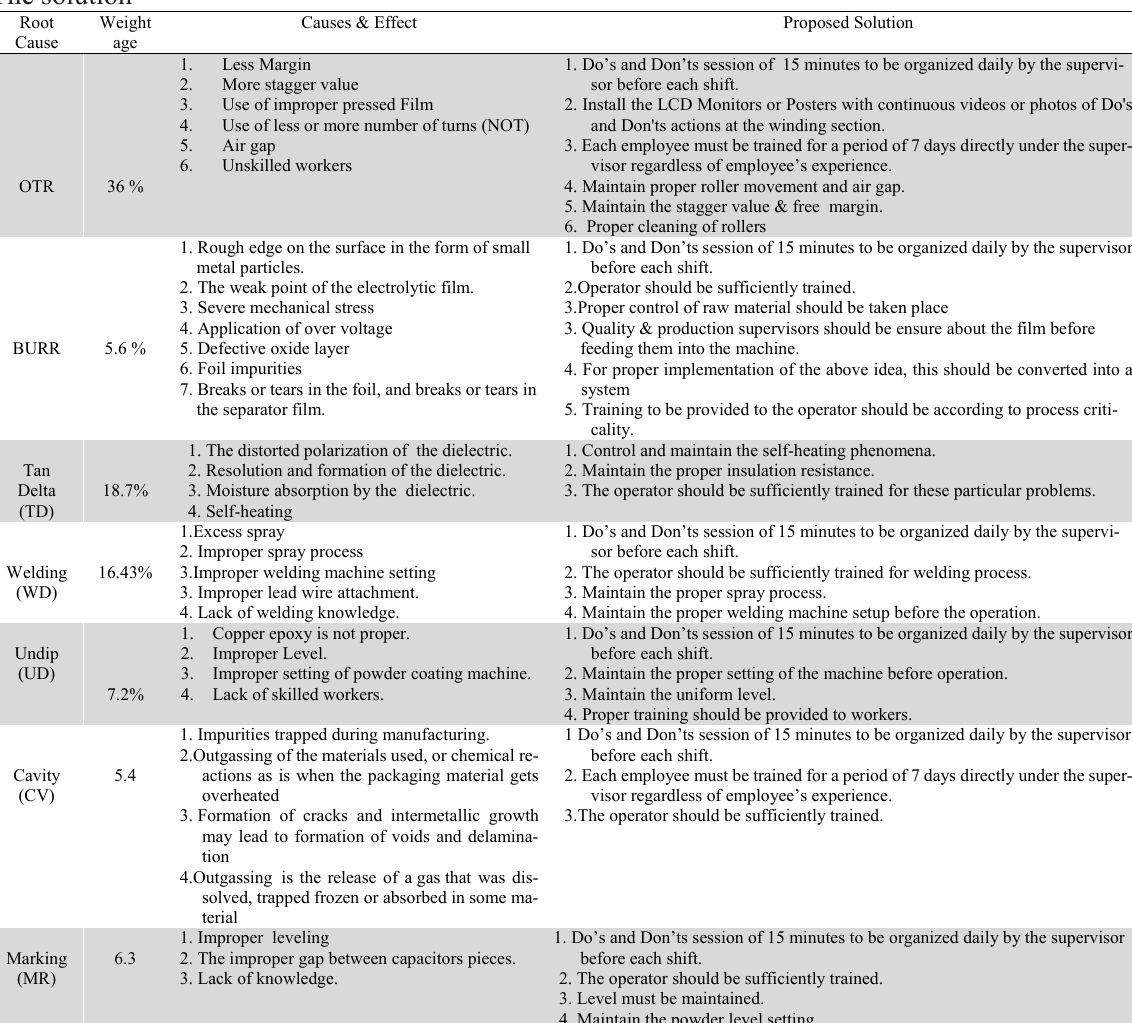
Causes & Effect Proposed